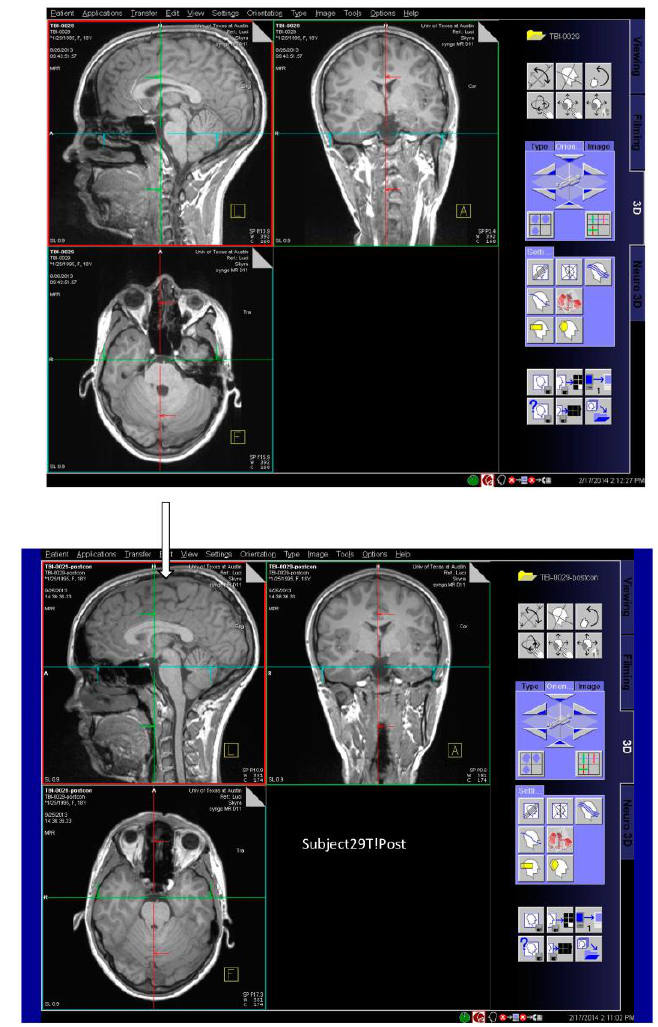
Figure 4. Images in three planes of a woman athlete before concussive event ( upper image); three planes of images of the same athlete several days after concussive event ( lower image). The widened sulci under the arrow in the region of the pre- to post-central sulci after concussion are visible compared with the preconcussion image in ( upper image).